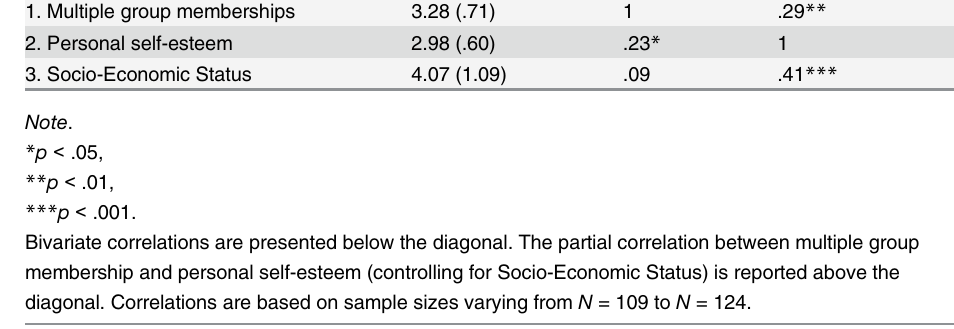
Table 2. Study 1b: Descriptive statistics and bivariate correlations for older adults in China. M (SD) 1 2